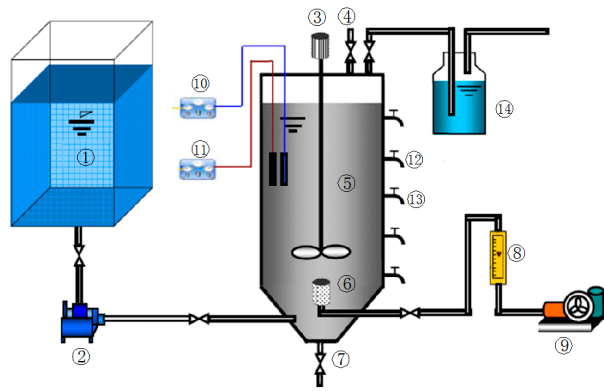
Figure 1. Apparatus for sludge acclimation. (1) Sewage tank, (2) pump, (3) rabbler, (4) gas sampling port, (5) ASBR reactor, (6) aeration device, (7) sludge outlet, (8) rotameter, (9) air-blower, (10) pH and digital thermometer, (11) ORP meter, (12) sample point, (13) discharge port and (14) absorption bottle for acidic gases.